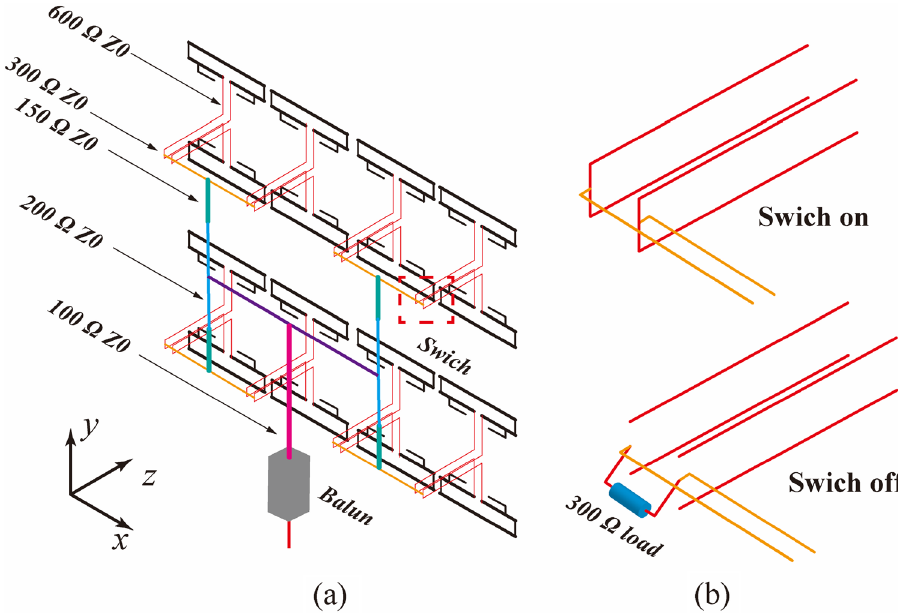
Figure 8. ( a ) Feeding network of the antenna array, ( b ) switch.